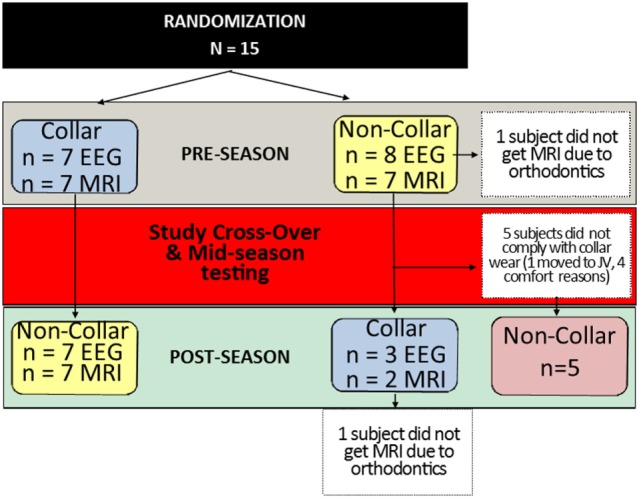
Study subject allocation following randomization. Subjects randomly assigned to the collar (n = 7) or no-collar group (n = 8) for the first half of the season were crossed-over at the mid-season time point. The number of subjects who completed each test (EEG and MRI) at each time point is indicated in the blue and yellow boxes. In the second half of the season, five subjects did not comply with wearing the collar, which created a second “No-Collar” group in the latter part of the season, as indicated in the red box.